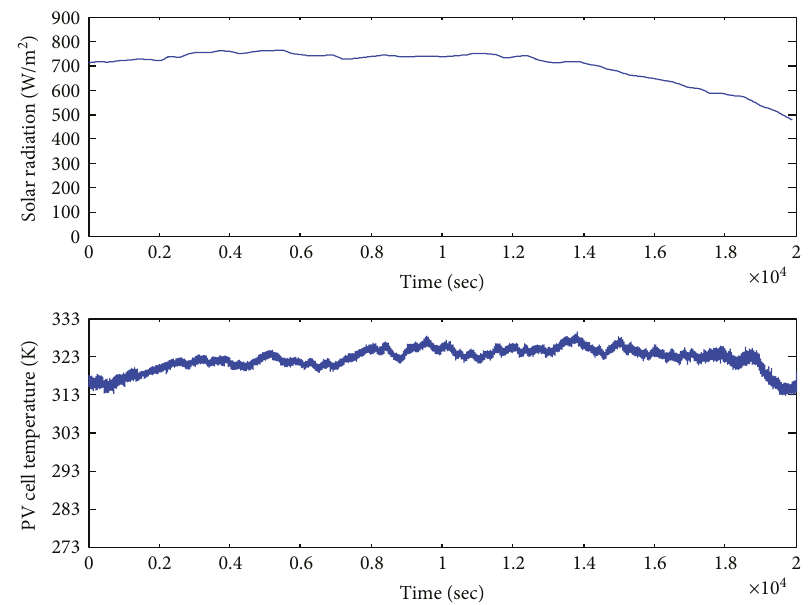
Figure 20: Changing the solar radiation and PV temperature on a sunny day. From 9:23AM to 3:00 PM.